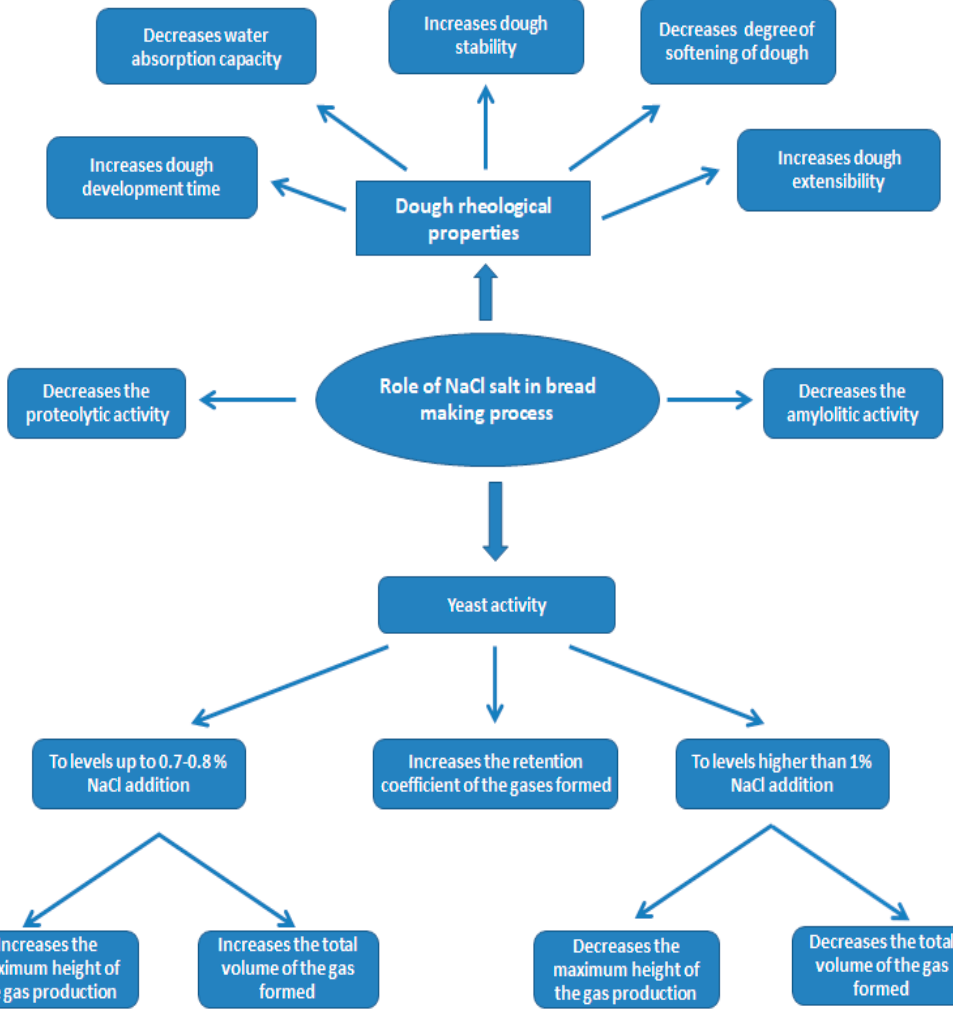
Figure 2. The role of sodium chloride in bread making process .